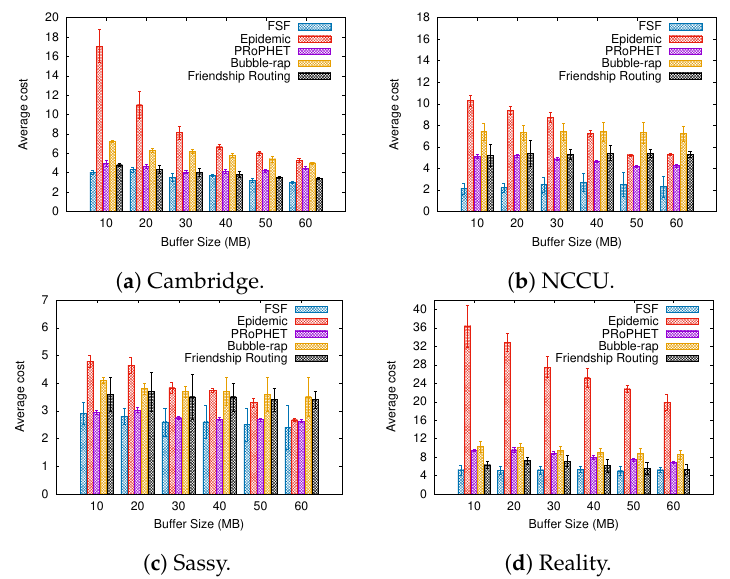
Figure 10. Average cost when varying the buffer